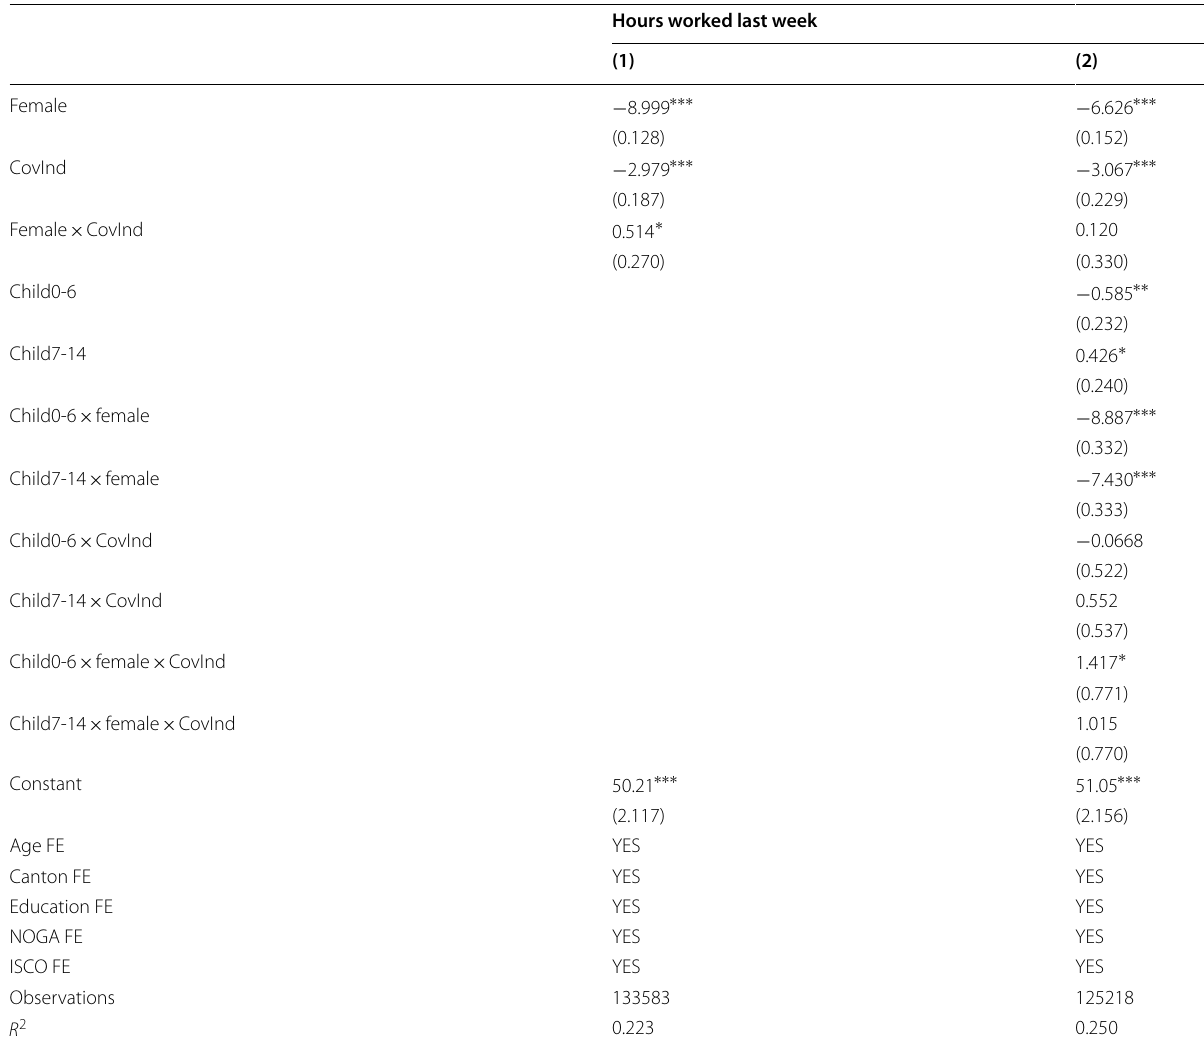
Table 18 The effect of COVID-19 and gender on hours worked